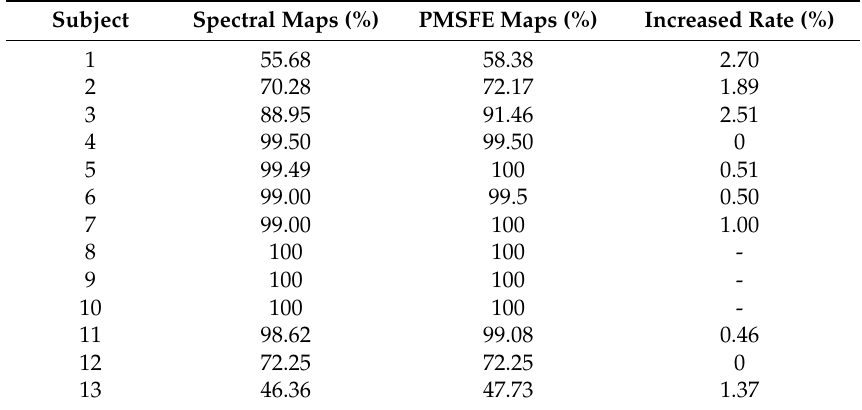
Table 3. The accuracy of spectral maps and PMSFE maps tested on 13 subjects and the rate of increase after using PMSFE maps.